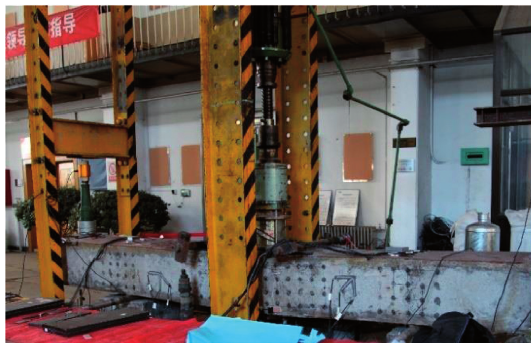
Figure 9: Specimen